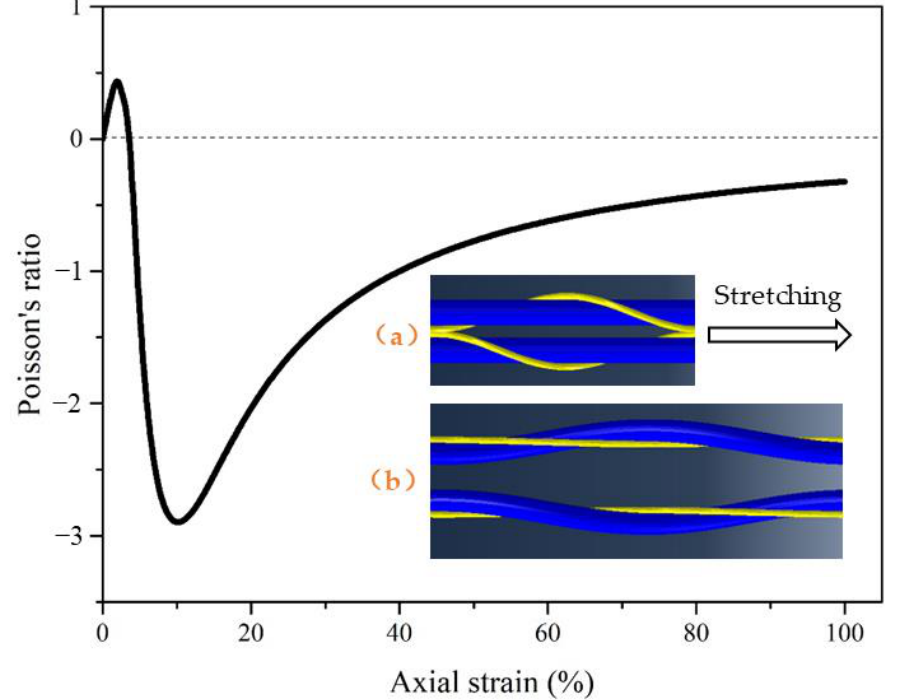
Figure 8. Poisson’s ratio and pore -opening effect of a pair of yarns under axial strain: ( a ) initial state; ( b ) stretching state. ( b ) stretching